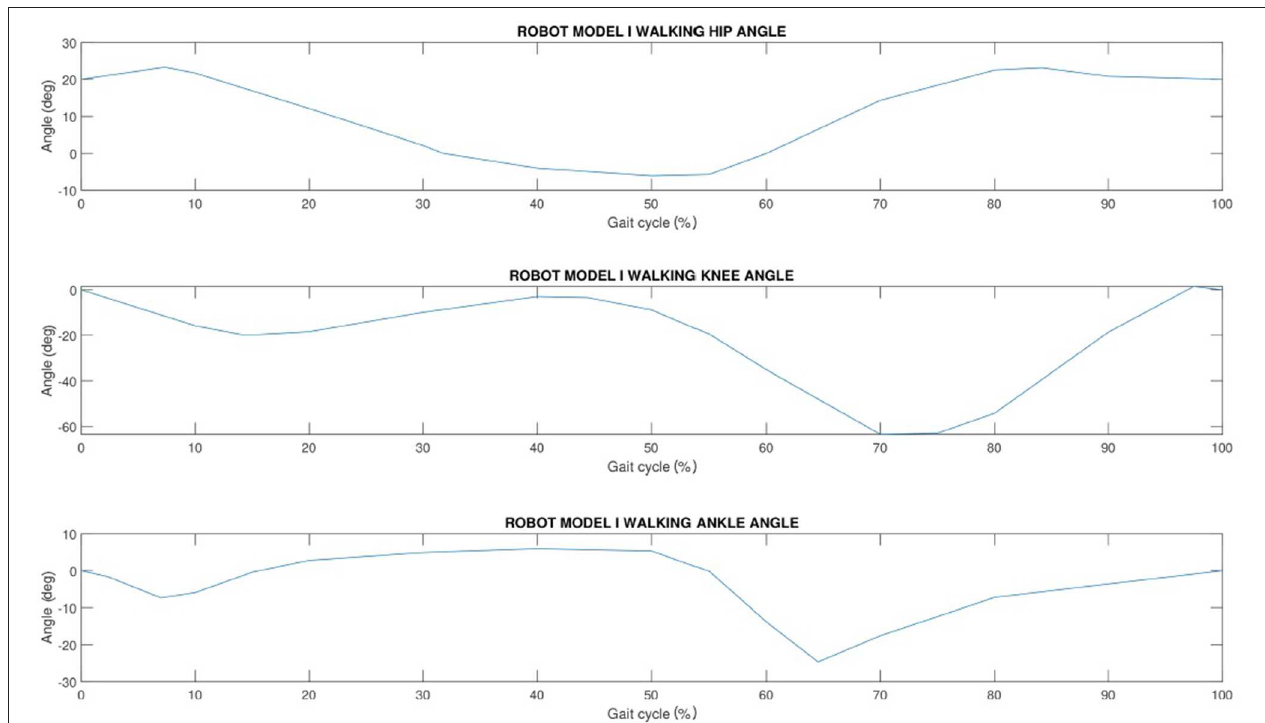
FIGURE 3 | Joint angle input for Robot model I walking